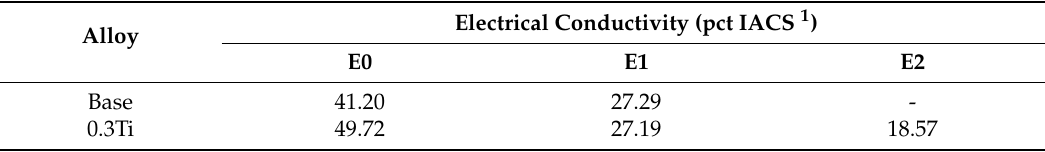
Table 3. Values of the electrical conductivity of the base and 0.3% Ti